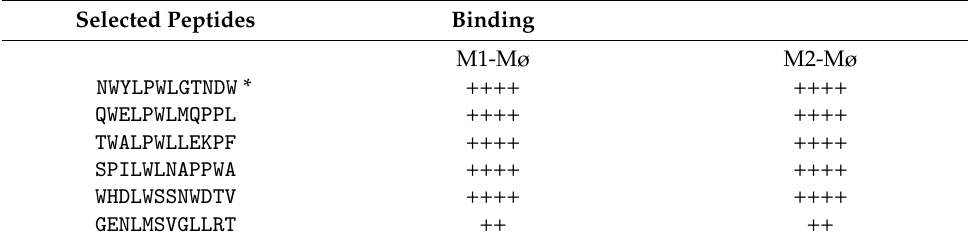
Table 1. Sequences of the phage-displayed